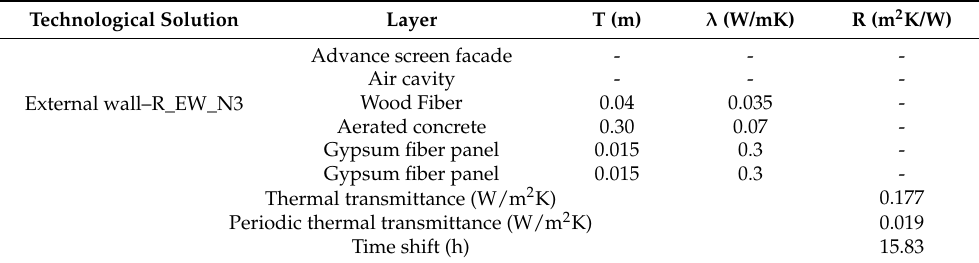
Table A24. Possible redevelopment measure for external wall characterized by the half value of the thermal transmittance of the reference building with advanced screen facade as external finishing